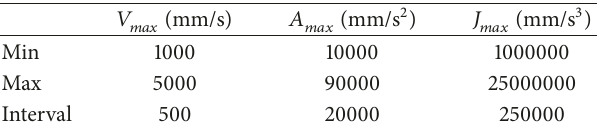
Table 1: Motion related